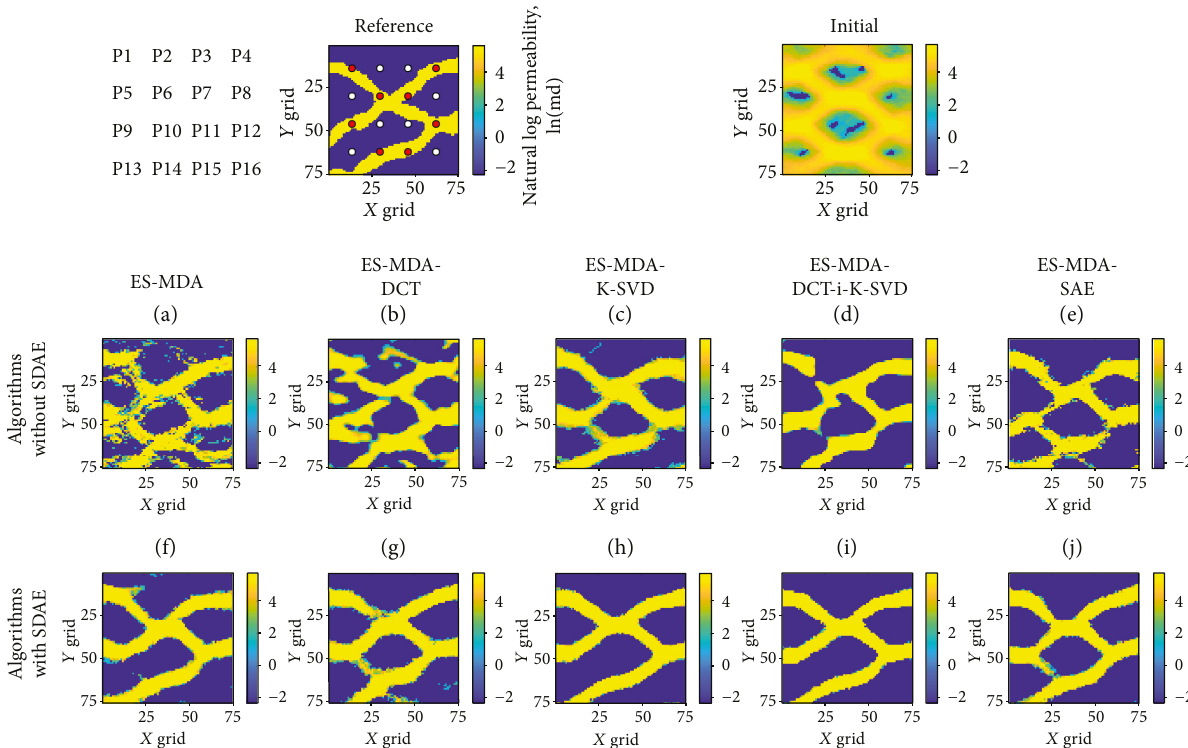
Figure 15: Permeability distributions of the ensemble mean maps obtained using the ten ES-MDA